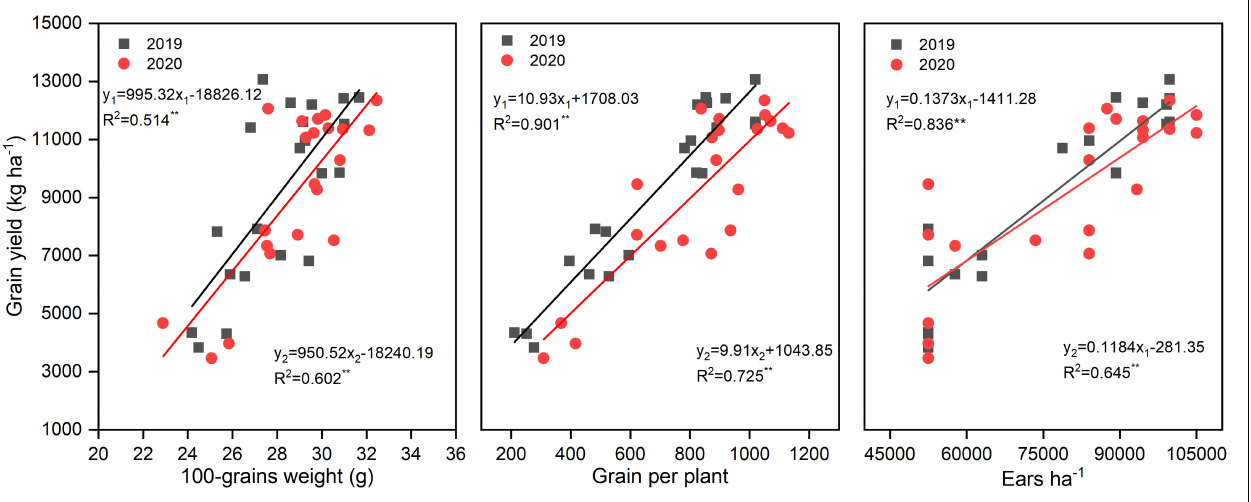
FIGURE 2 | Correlations between yield, 100-grains weight, grains per plant, and ears ha − 1 . y 1 and y 2 represent and 2020 simulation equation,